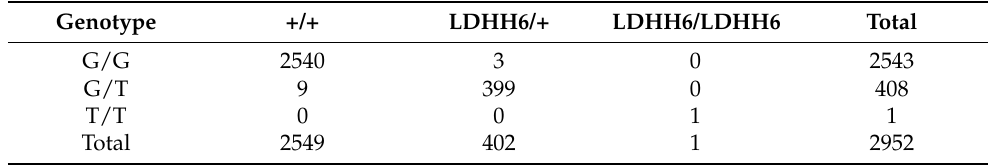
Table 2. Contingency table between LDHH6 status and genotype at c.521G > T in CCDC65 .